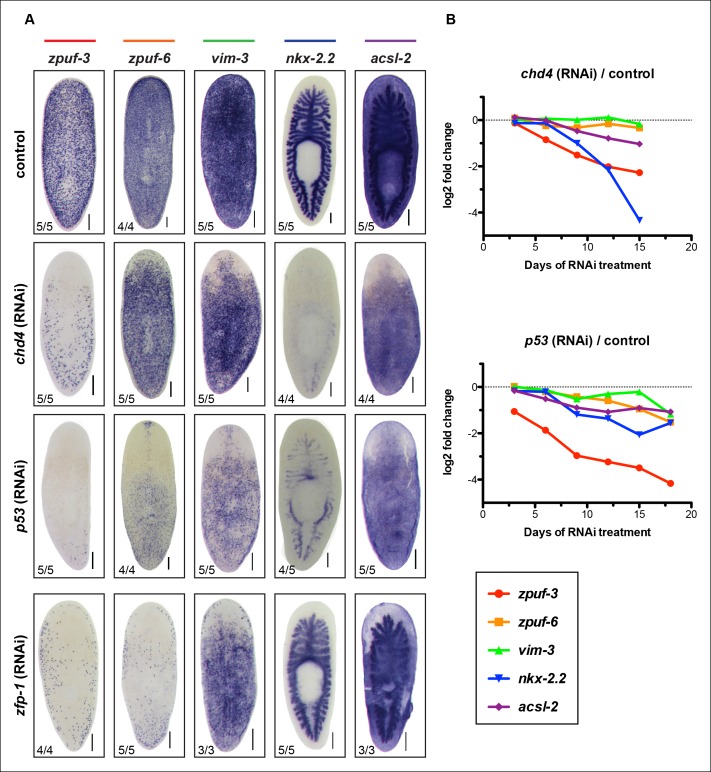
Validation of select candidate genes in chd4, p53 and zfp-1 RNAi conditions by WISH.(A) Representative WISH of candidate genes encompassing the full range of expression patterns in control, chd4 and p53 RNAi animals fixed at 3Fd21 (For nkx-2.2, 3Fd18). Genes expressed in mesenchyme, epidermis and gut are reduced in chd4 and p53 RNAi animals. Genes expressed in mesenchyme and epidermis are also reduced in zfp-1(RNAi) animals (3Fd21) but gut expression is not affected. Scale bar: 200 μm. (B) Plot of log2 ratios of candidate genes from (A) in chd4(RNAi) (top panel) and p53(RNAi) (bottom panel) RNA-seq time course.